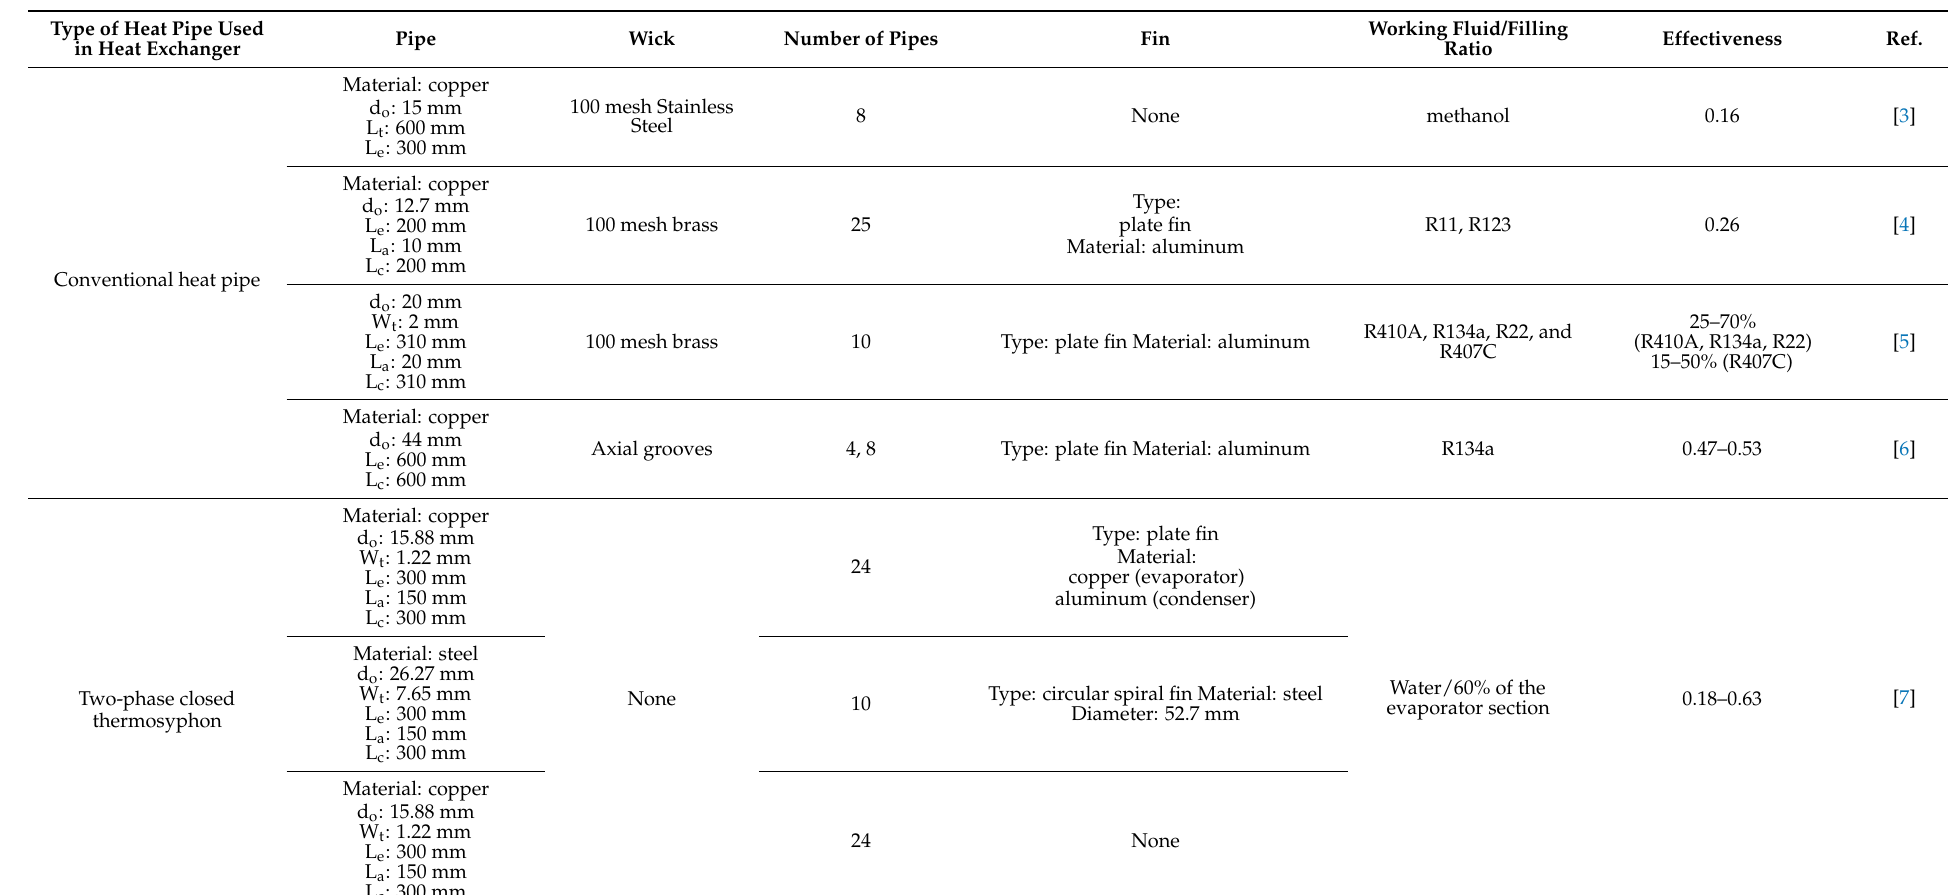
Table 1. Summary of the geometric characteristics, working fluid and performances of HPHXs based on CHP, TPCT and PHP.